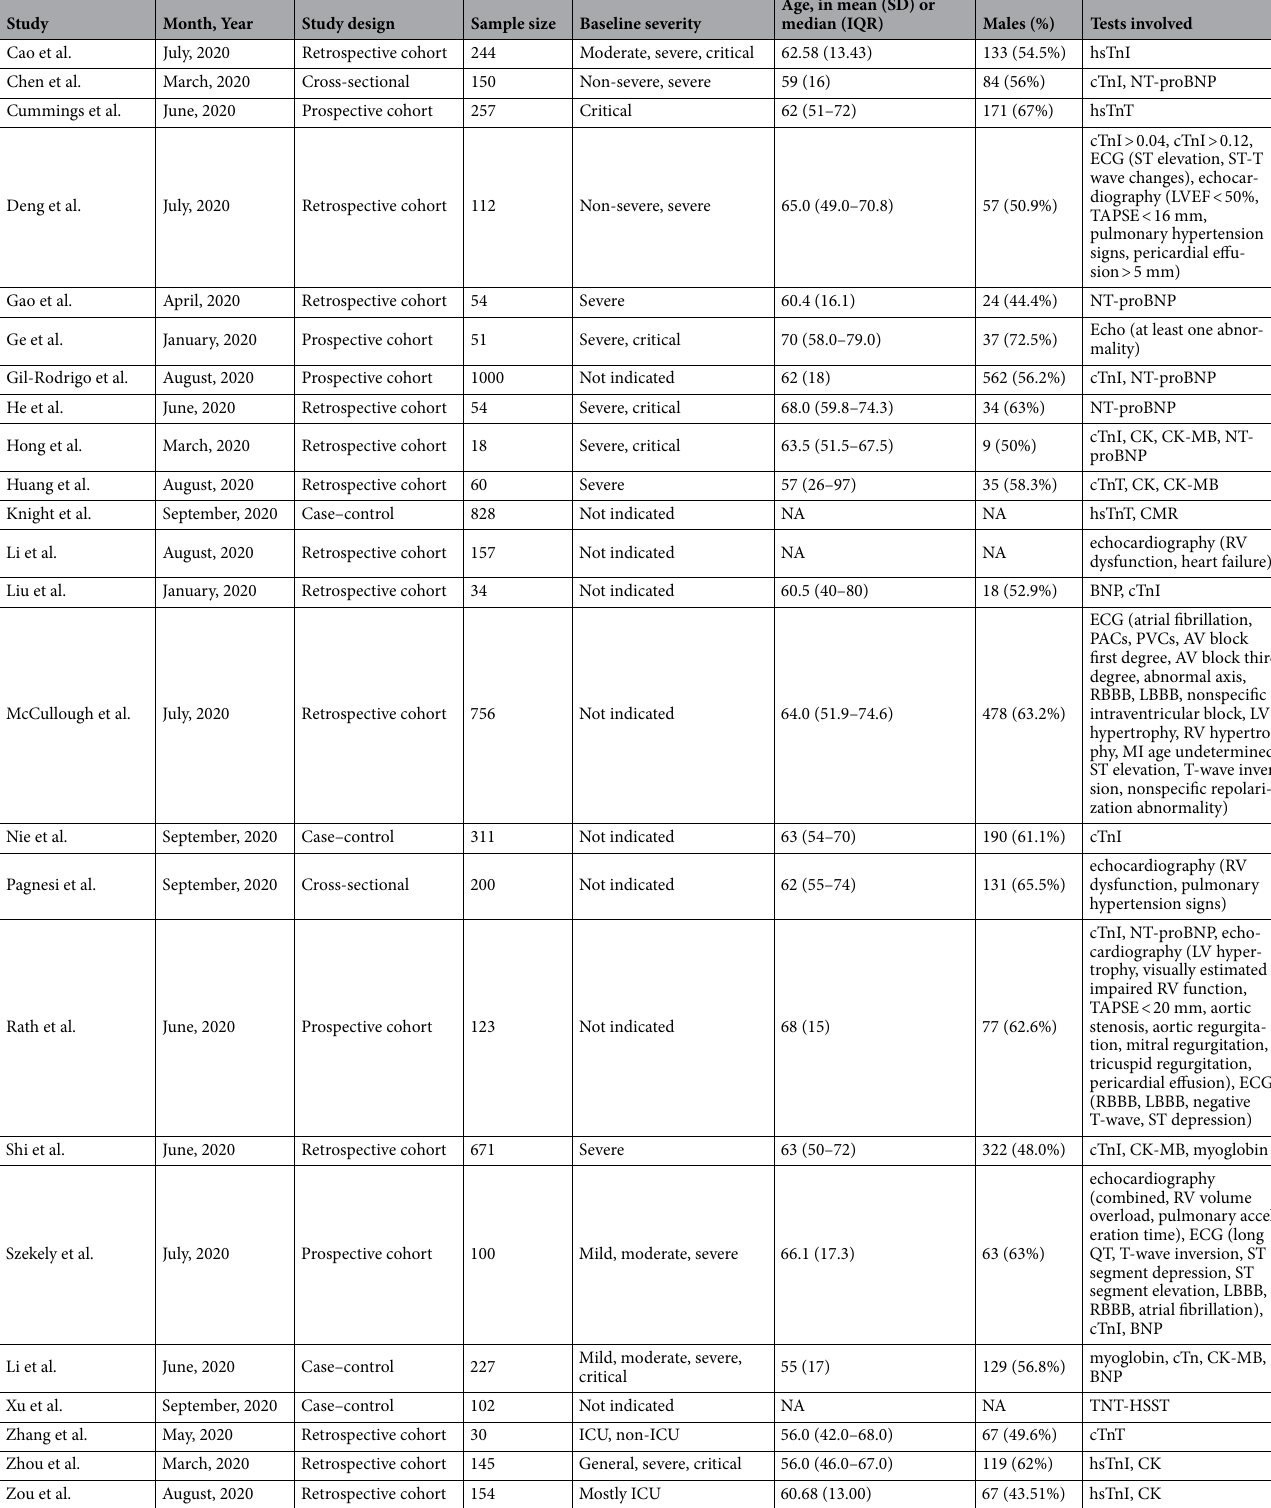
Table 1. General characteristics of included